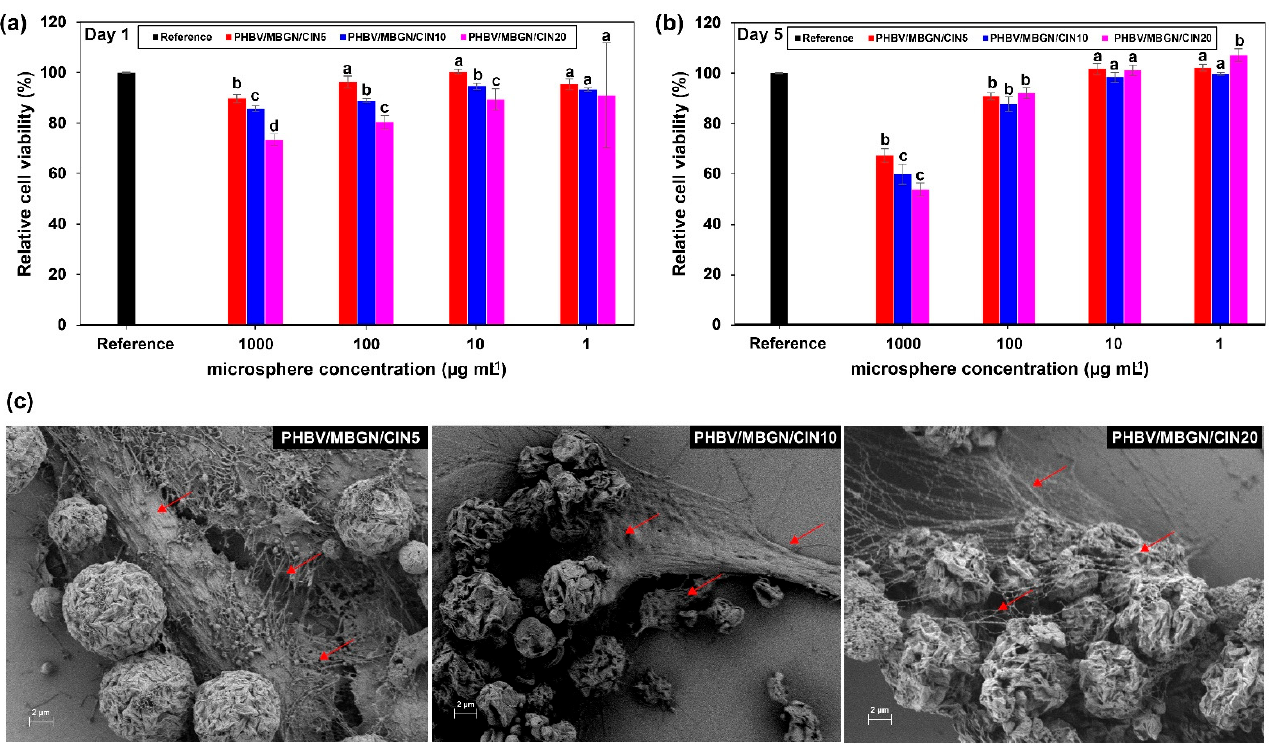
Figure 5. Cytotoxicity test of osteosarcoma MG-63 cells on the different microsphere concentrations (1000, 100, 10, and 1 µg mL –1 ) for ( a ) day 1 and ( b ) day 5. The relative cell viability in free microsphere medium was used as reference. Experimental data are reported as mean ± standard deviation ( n = 3). Means followed by the different letters within columns indicate a significant difference at p < 0.05 using Duncan’s new multiple range test. Each different microsphere concentration was analyzed separately; ( c ) Scanning electron micrographs showing cell adhesion and attachment on the surface of PHBV/MBGN/CIN5, PHBV/MBGN/CIN10, and PHBV/MBGN/CIN20 microspheres at the highest concentration of microspheres, i.e., 1000 µg mL –1 , after 5 d of culture, the arrows indicate the presence of cells or filopodia.